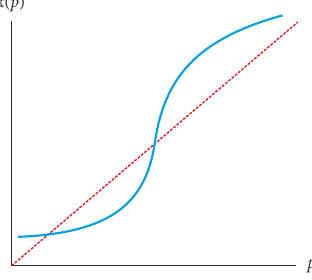
Figure 3. The probability weighting function of